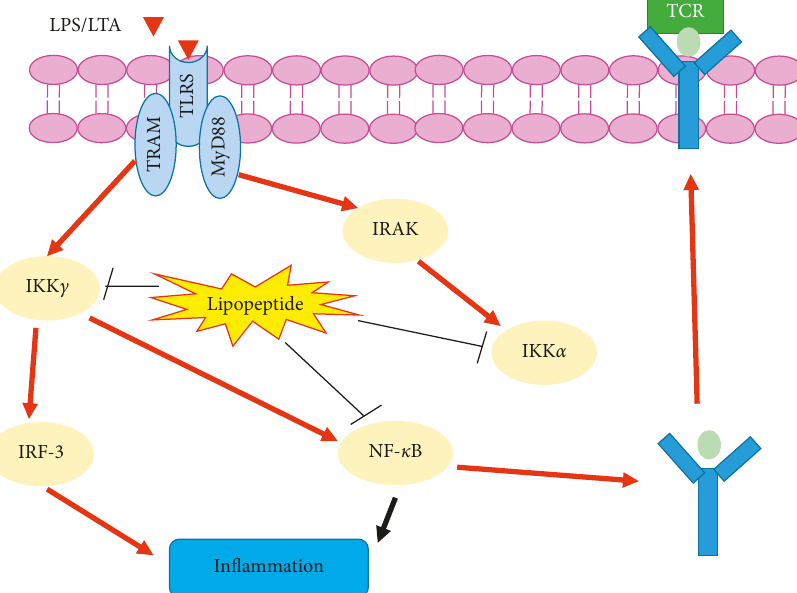
Figure 3: The proposed anti-inflammatory mechanism of Bacillus subtilis